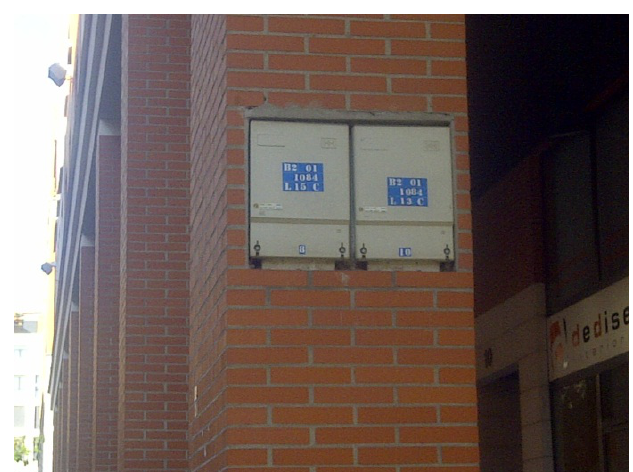
Figure 4. Fuse box location in a